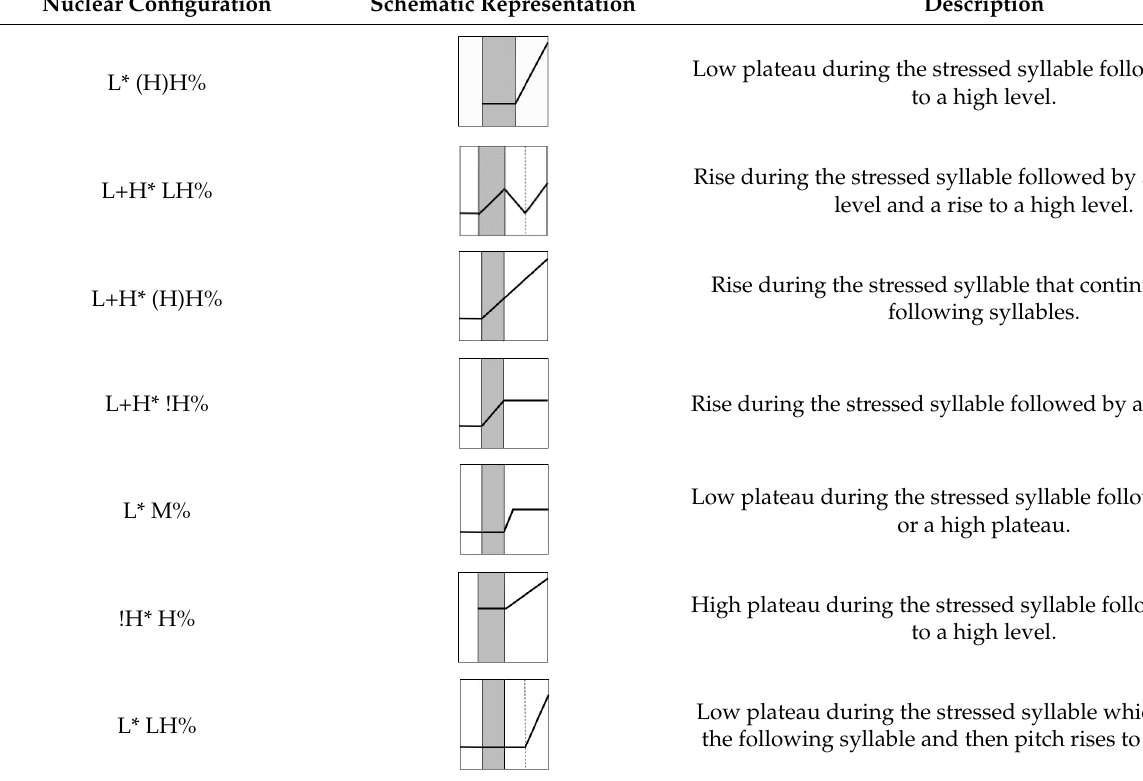
Table 2. Types of nuclear configuration considered in the present study.